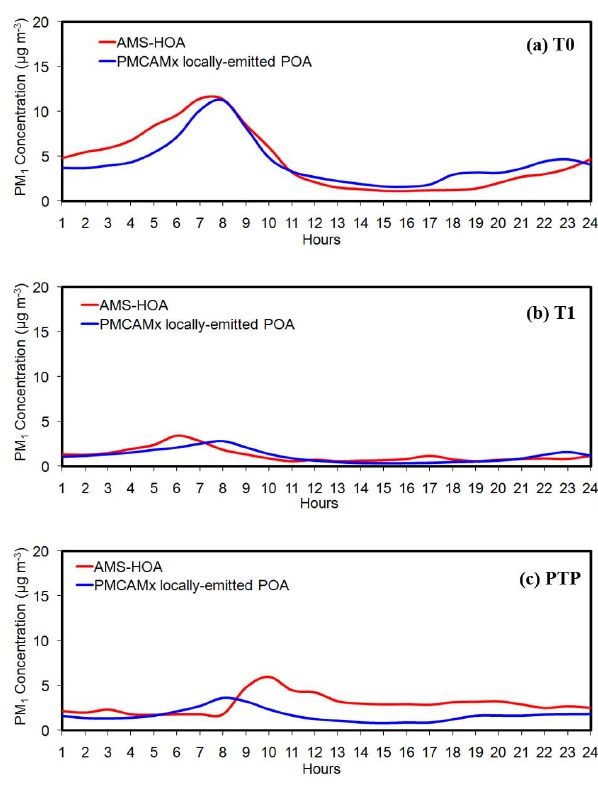
Fig. 8. Comparison of model episode average diurnal predictions for PM 1 locally-emitted primary organic aerosols against AMS- HOA taken during the MILAGRO campaign in 4–30 of March 2006 at (a) T0, (b) T1 and (c) PTP.